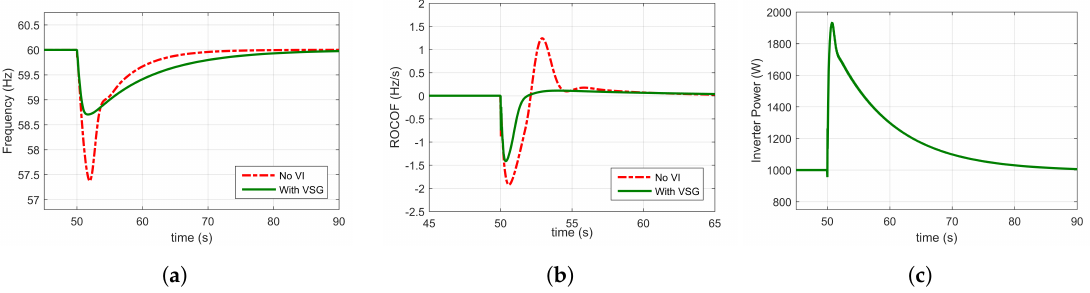
Figure 14. Simulation results from a virtual synchronous generator: ( a ) system frequency after a step-increase of 2 kW load; ( b ) ROCOF after a step-increase of 2 kW load; ( c ) increase in inverter power as a response to system frequency decrease [45,46].